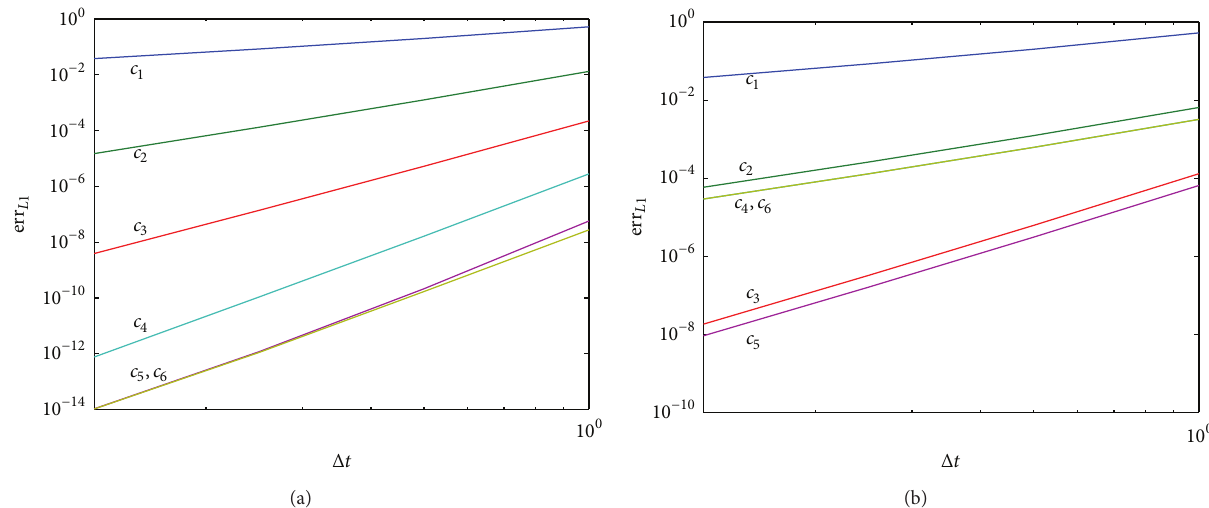
Figure 3: Numerical errors of the one-sided and two-sided splitting schemes: one-sided splitting over 𝐴 (a) and two-sided splitting scheme alternating between 𝐴 and 𝐵 (b) with 1, ...,6 iterative